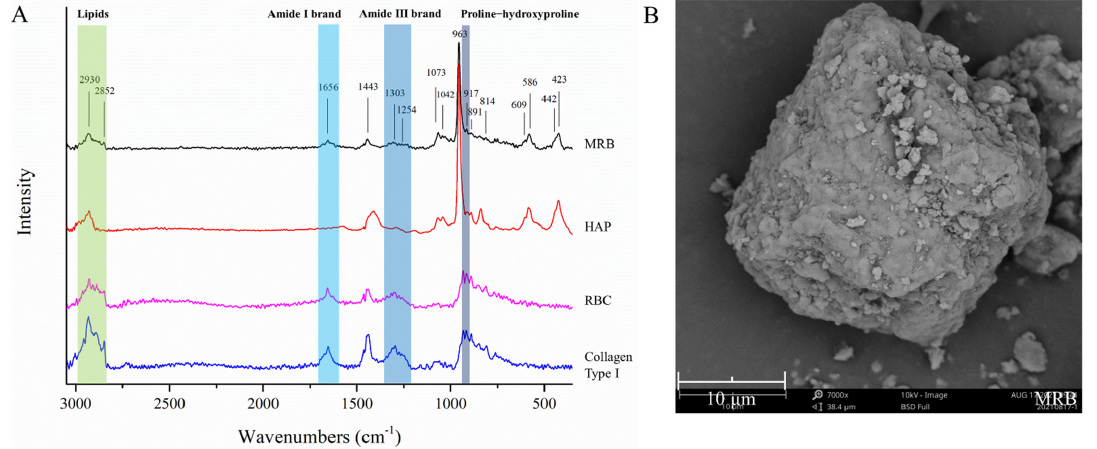
Figure 2. ( A ) Raman spectrogram of MRB: compared with synthetic hydroxyapatite (HAP), RBC and Type I collagen standard (from bovine Achilles tendon). ( B ) Micromorphology of the raw material (MRB).